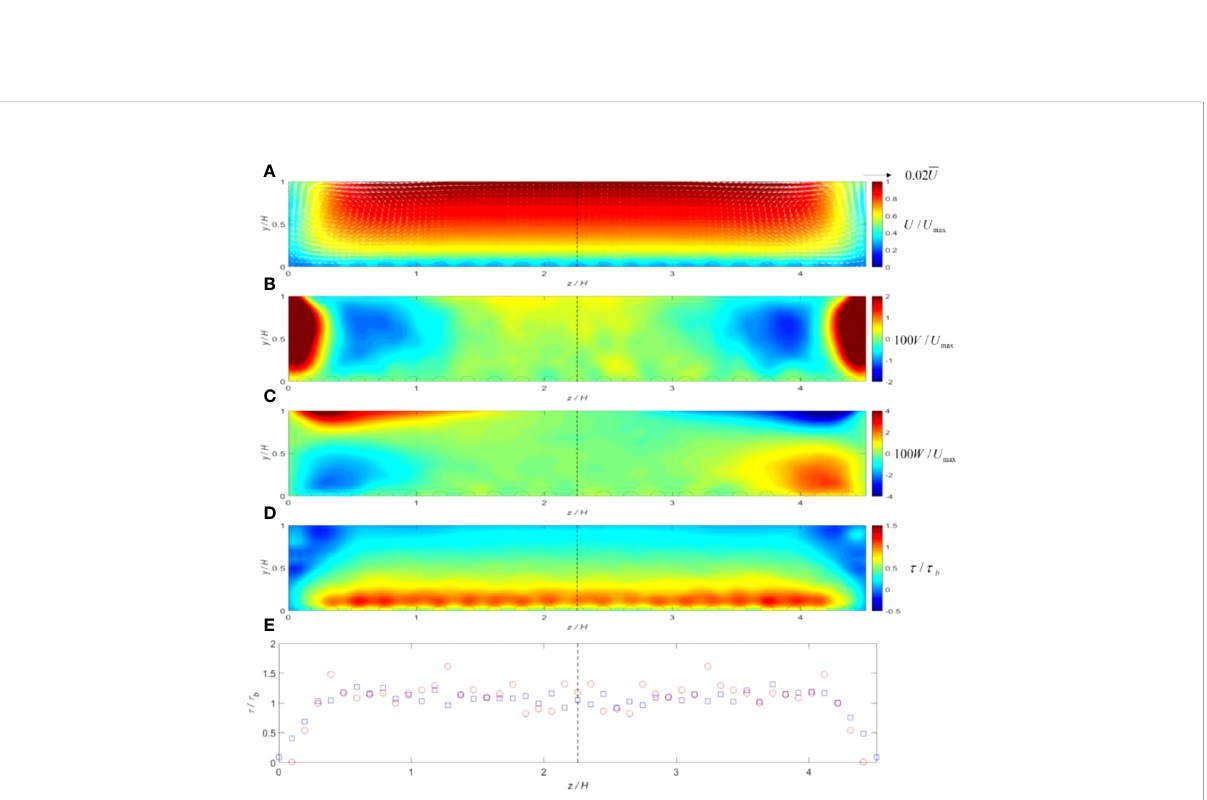
FIGURE 10 (A – E) Cross-sectional distributions of hydrodynamic parameters computed for fl ow condition 4 (deep depth: Re = 43,000) including the roughness elements: normalized mean (A) streamwise velocity with vector fi eld; (B) vertical velocity; (C) lateral velocity; (D) shear stress; and (E) measured and computed bed shear stress (circles: exp data; squares: SPH). The dashed semicircles at the bottom of each panel represent the rough bed